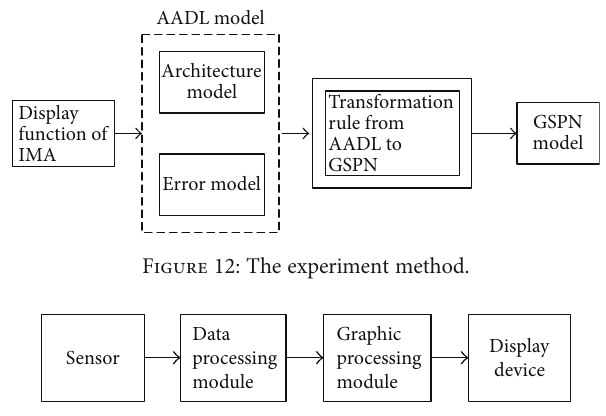
Figure 13: Architecture of basic integrated cockpit display